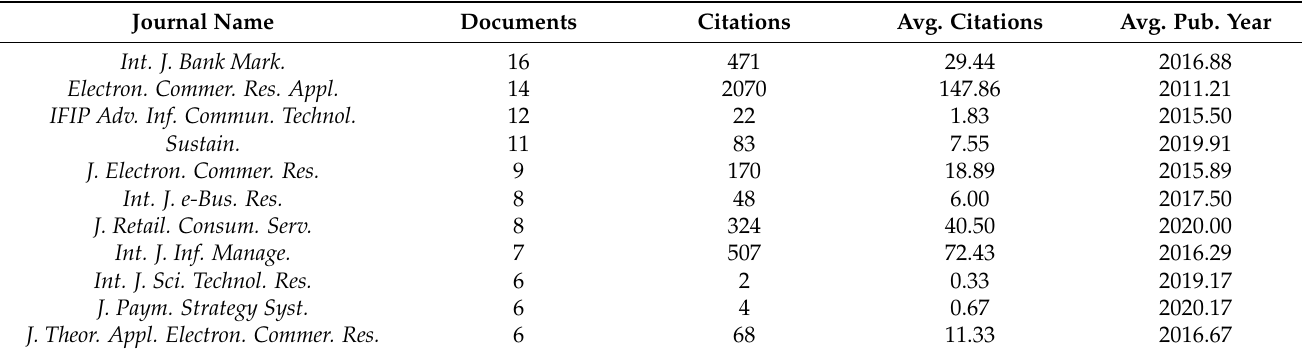
Table 2. Influential journals in the field of digital